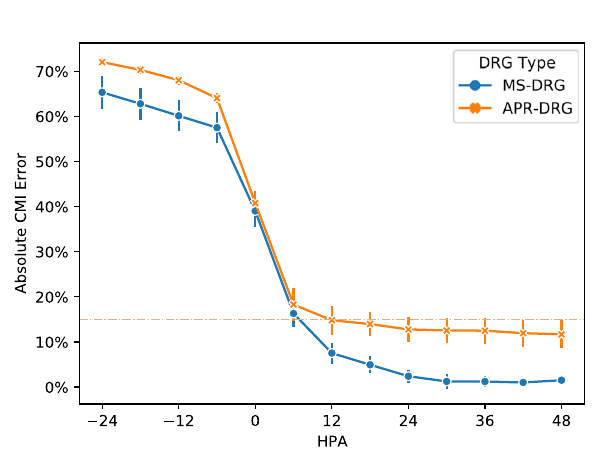
Fig. 1 Absolute error on CMI across HPA. The plot shows the mean and standard deviation of absolute CMI errors at different HPA for MS-DRG test cohort (1648 patient stays) and APR-DRG test cohort (2252 patient stays), averaged over fi ve models developed using different train folds. Predictions were made on the 6-h intervals from 24 h before ICU admission ( − 24 HPA) to 48 HPA. CMI case mix index, HPA hour